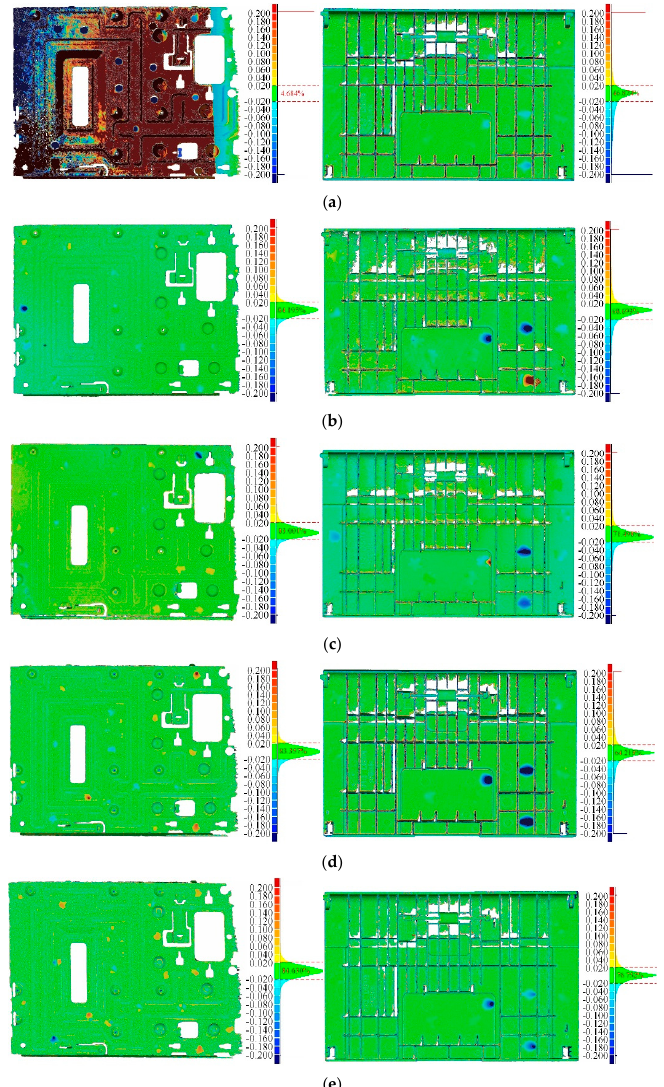
Figure 18. Cloud to mesh (C2M) error colormaps for surface reconstructions of two thin products; the left column is the reconstruction of the sheet metal part, and the right column is the reconstruction of the plastic shell; The compared method are ( a ) Tubi ć et al. [6]; ( b ) Creaform [7]; ( c ) Scantech [8]; ( d ) our real-time processing approach; and ( e ) our post-processing approach. In each subfigure, the frequencies with C2M errors in the interval of [ − 0.02 mm, 0.02 mm] are also indicated.